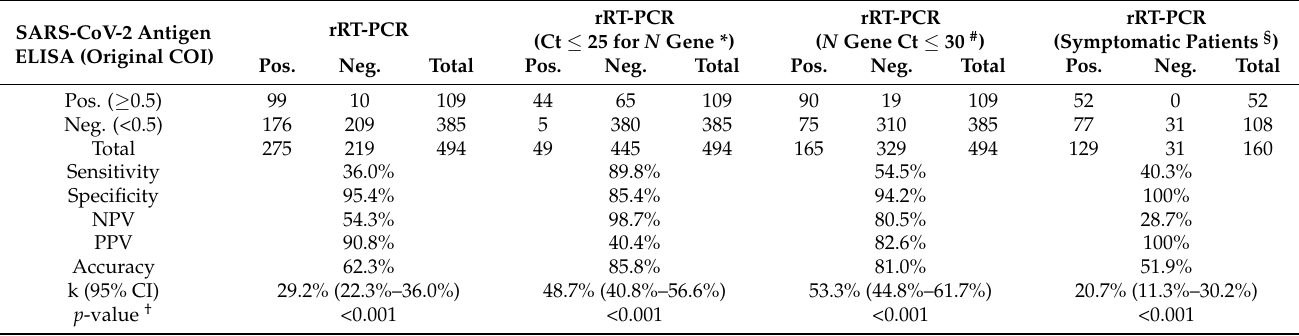
Table 7. Results of reference method (rRT-PCR) and tested method (SARS-CoV-2 Antigen ELISA) using the manufacturer’s specified cut-off